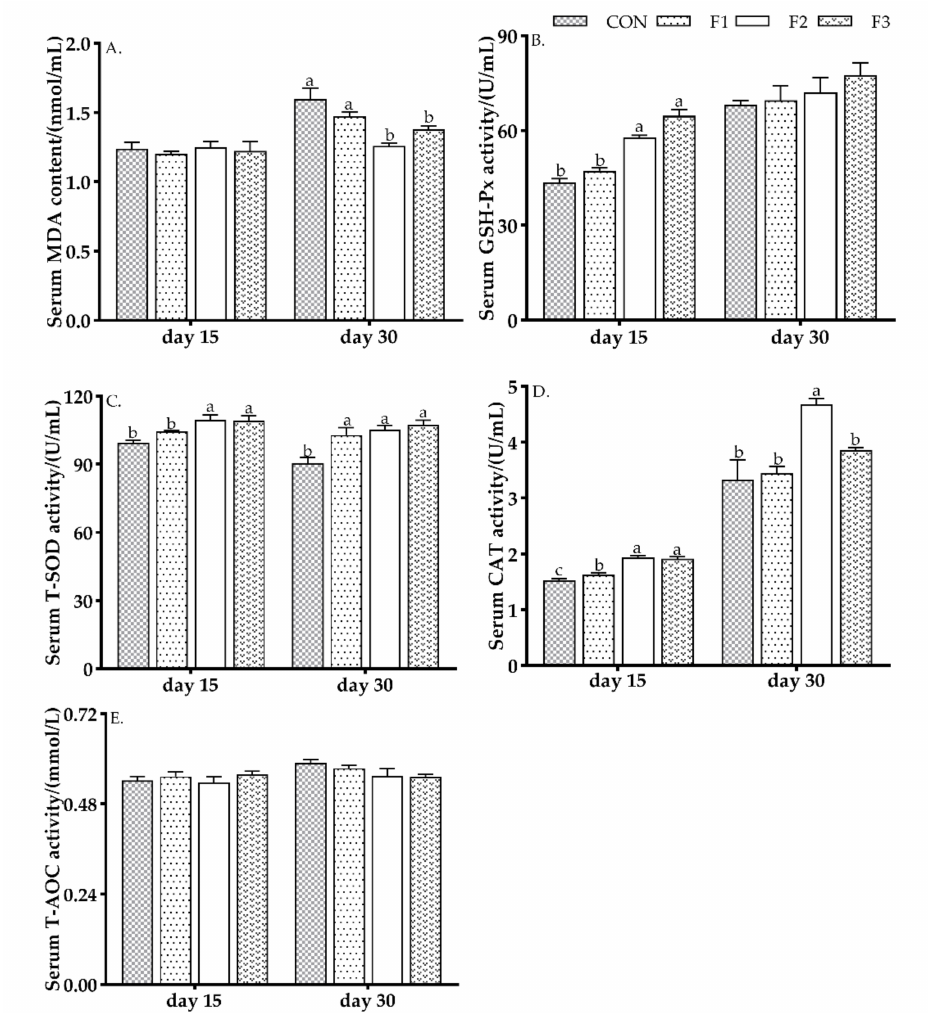
Figure 1. Effects of dietary fucoidan administration on antioxidant indexes in weaned kids. ( A ) serum MDA content; ( B ) serum GSH-Px activity; ( C ) serum T-SOD activity; ( D ) serum CAT activity; ( E ) serum T-AOC activity. Results are presented as mean ± SEM ( n = 6). a, b, c means significantly different ( p < 0.05). CON, basal diet; F1, basal diet +0.1% fucoidan; F2, basal diet +0.3% fucoidan; F3, basal diet +0.5% fucoidan. MDA, malondialdehyde; GSH-Px, glutathione peroxidase; T-SOD, total superoxide dismutase; CAT, catalase; T-AOC, total antioxidant